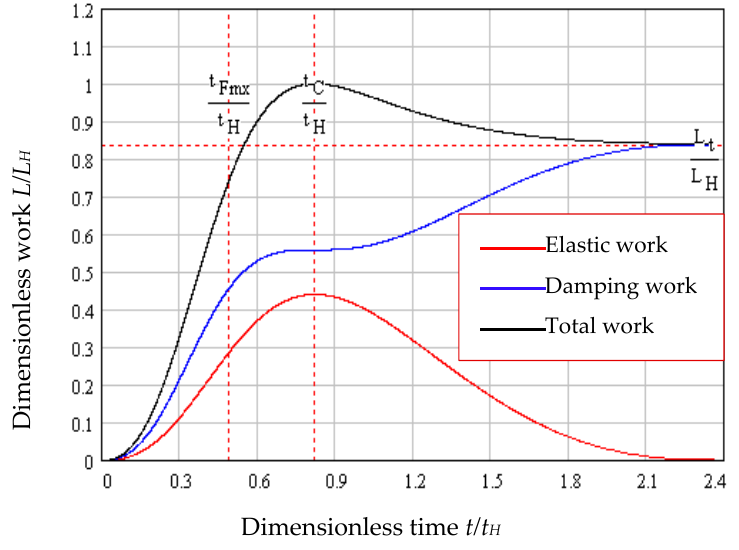
Figure 15. Time variation of elastic force, damping force and total force.